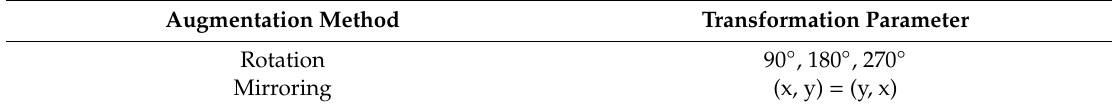
Table 3. Data augmentation